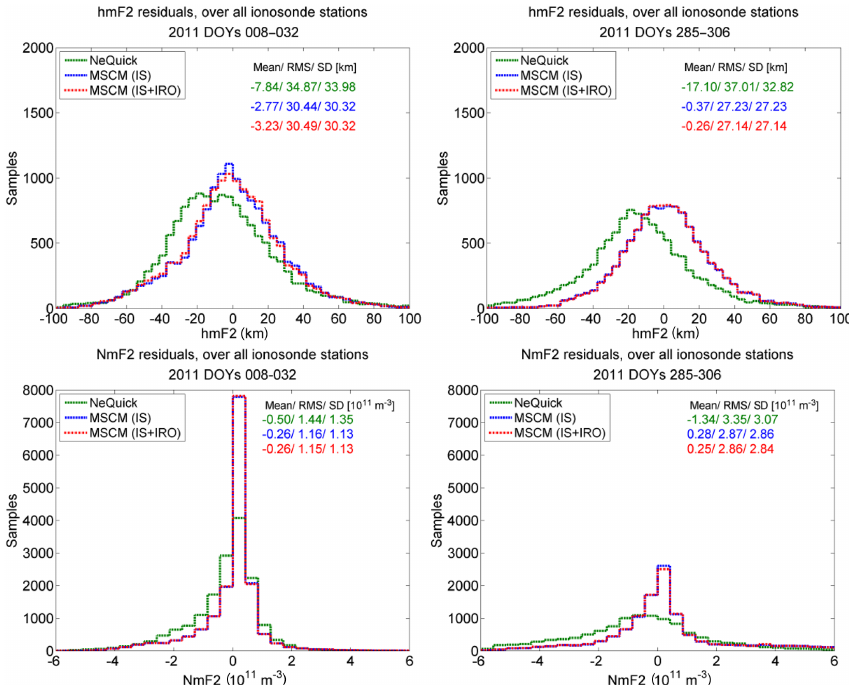
Figure 9. Histograms of hm F2 (top row) and Nm F2 (bottom row) residuals for the periods DOYs 008–032 in 2011 (left column) and DOYs 285–306 in 2011 (right column).